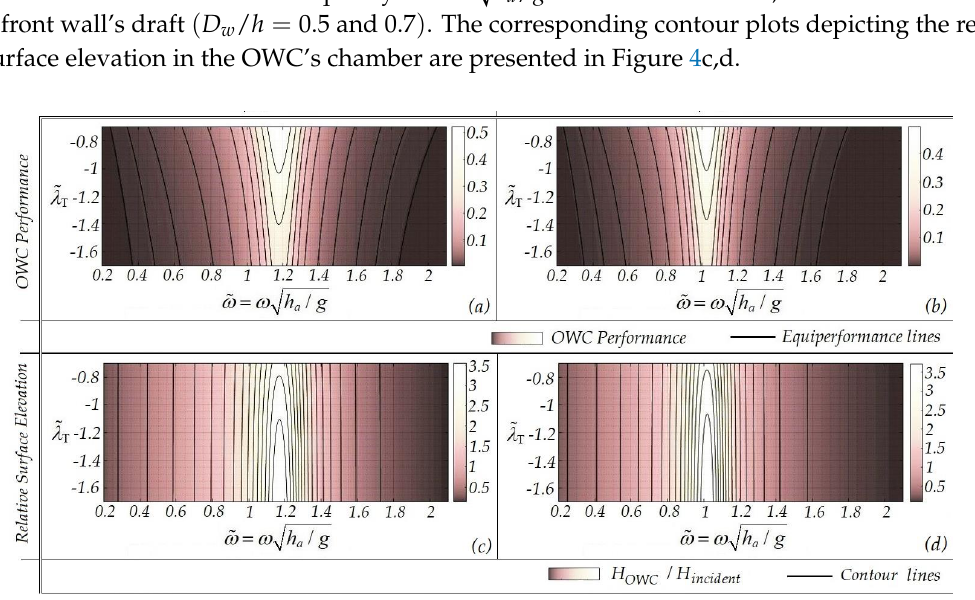
Figure 4. Contour plots of the OWC’s performance in uniform bathymetry for di ff erent values of the front wall’s draft D w / h = 0.5 ( left column ) and D w / h = 0.7 ( right column ). ( Parameters : h a = h b = 10 m , h c = 7 m , d = 0.5 m )